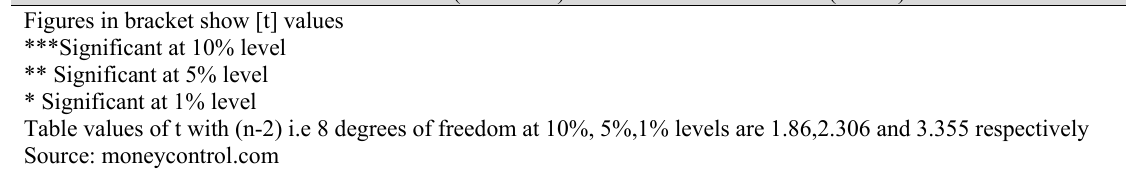
Table values of t with (n-2) i.e 8 degrees of freedom at 10%, 5%,1% levels are 1.86,2.306 and 3.355 respectively Source: